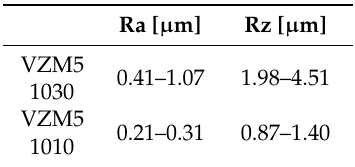
Table 19. Summary of surface roughness values of the hard machining tests, for inserts of type 1030 and